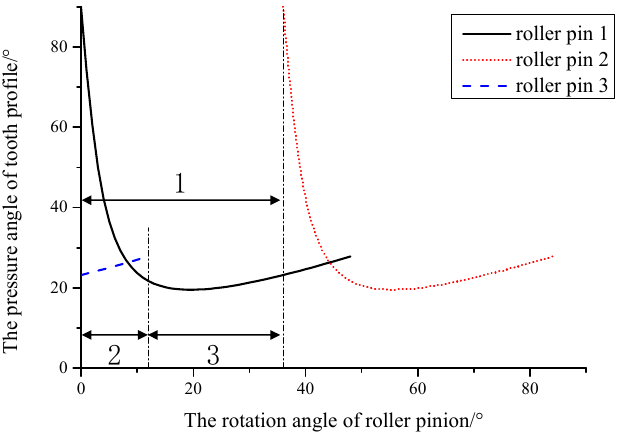
Figure 19. Time-varying curve of pressure angle of the trochoidal roller pinion rack. Since the output of the trochoid roller pinion rack is a circular motion, it is more practical to convert the meshing stiffness into the torsional stiffness on the roller pinion. The meshing stiffness k rp of the trochoid roller pinion rack is defined as the torque value required for the roller pinion to produce 1 rad torsional deformation, which is the deformation of the tangential direction of the meshing point converted to the deformation on the roller pinion. The pressure angle of the two meshing points in the double-tooth meshing area of the trochoid roller pinion rack is quite different, and the normal direction of the meshing point is not the same as the tangential direction of the roller pinion where the meshing point is located. Therefore, it is necessary to convert the meshing stiffness at the two meshing points during calculation. The normal meshing stiffness k of the meshing point is calculated by the energy method, and then it is first converted into the tangential meshing stiffness k t of the roller pinion, and then k t is converted into the torsional meshing stiffness k rp of the roller pinion. The conversion method between the stiffnesses is described as following. As shown in Figure 20, D i represents the i -th ( i = 1,2) meshing point, O is the pitch node of the rack, D i O represents the force direction at the meshing point D i , and l i represents the tangent direction of the meshing point D i on the roller pinion direction, and θ i represents the angle between the force direction and the tangent direction of the meshing point D i , R i represents the distance between the meshing point D i and the O’ which is the center of the roller pinion. Using the energy method, the meshing stiffness k i of D i can be directly calculated, the normal meshing stiffness k i is in the D i O direction. The meshing stiffness of the two meshing points is superimposed as the system normal meshing stiffness k . The calculation method of the tangential meshing stiffness k t of the trochoid roller pinion rack is shown in Equation (7), and the calculation method of the meshing stiffness k rp is shown in Equation (8).